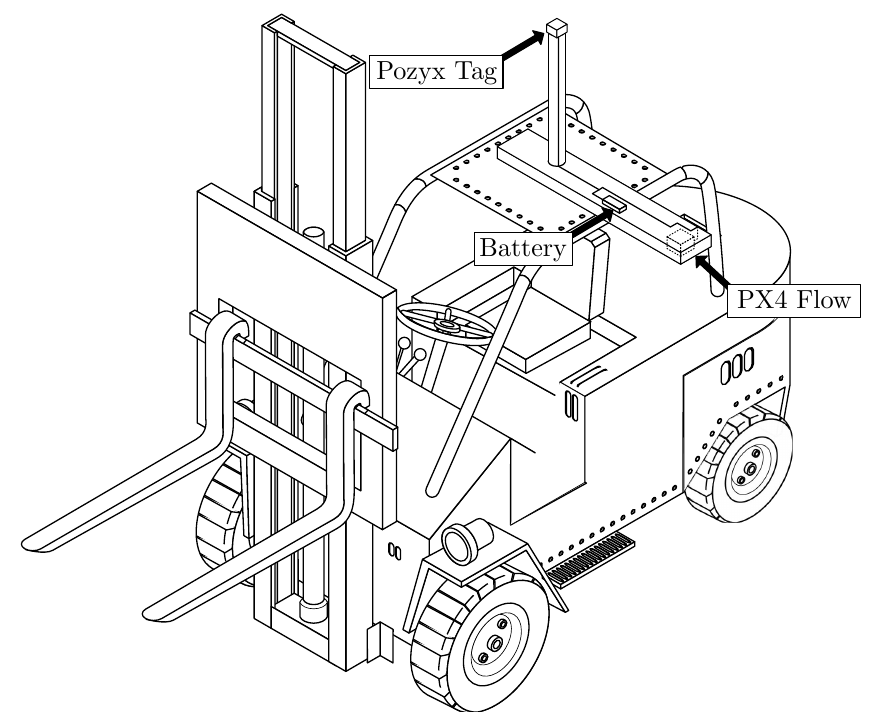
Figure 6. Sensor placement on the